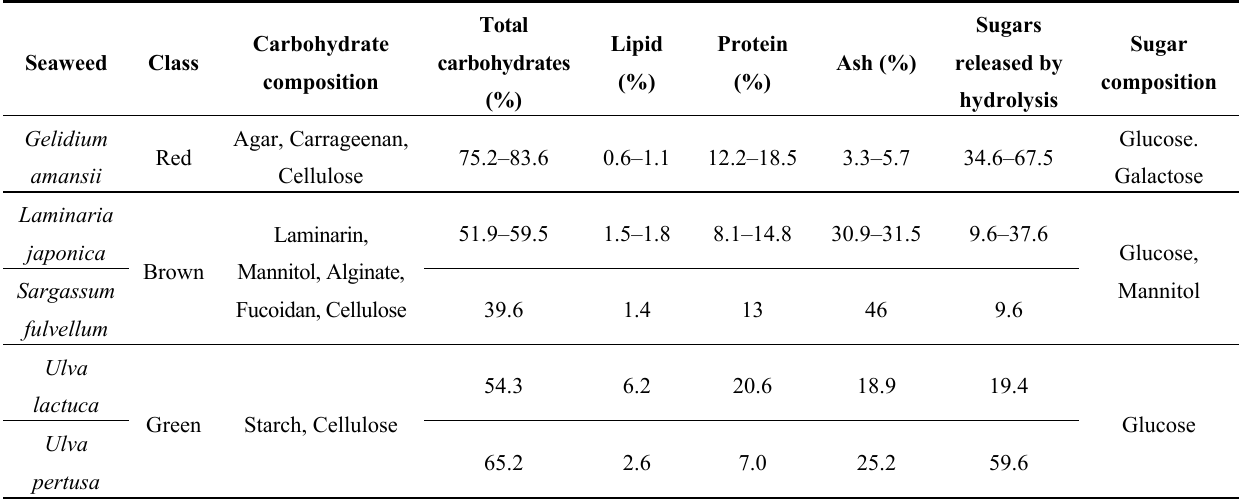
Table 4. Seaweed composition and sugars released by hydrolysis (% w / w dry biomass) for a variety of species [1].